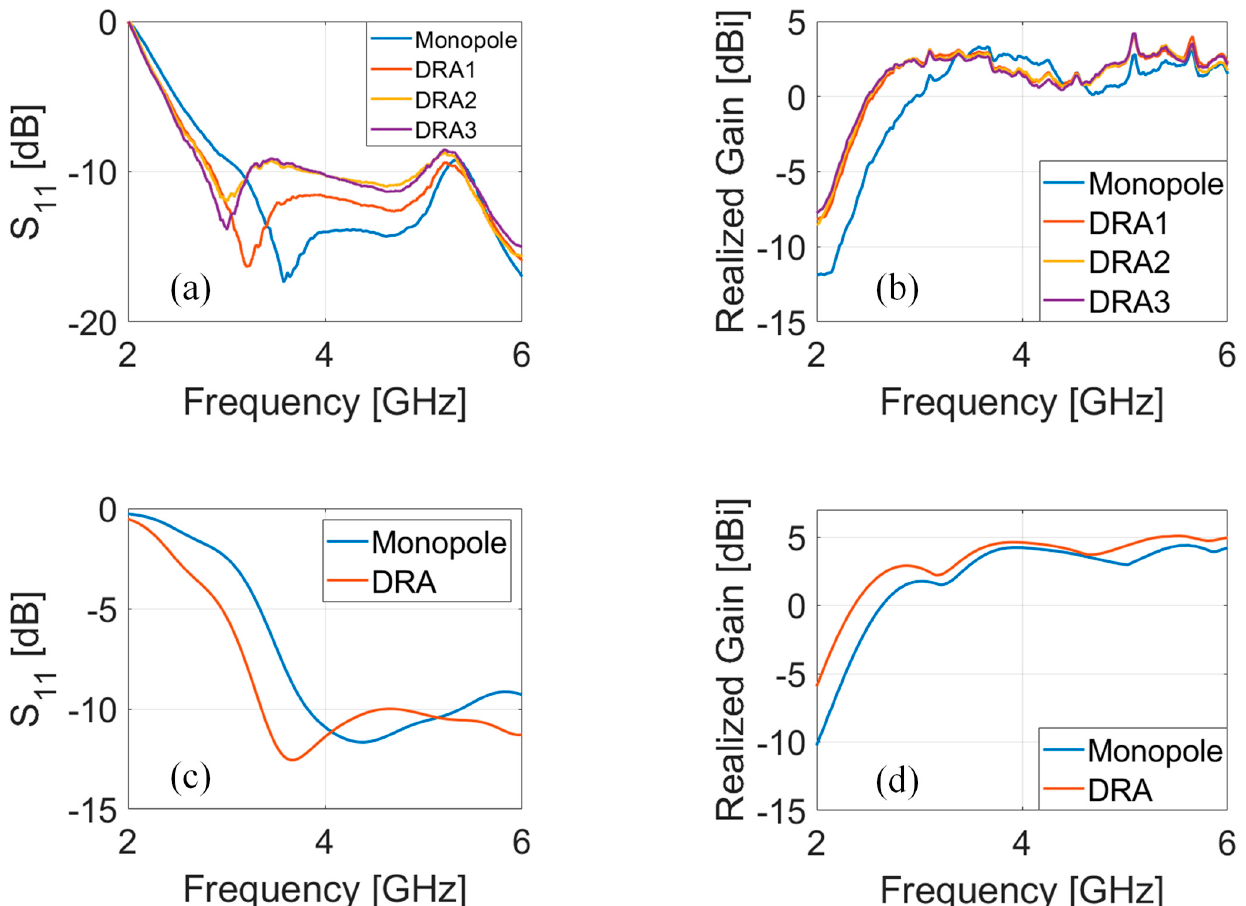
Figure 6. ( a ) Measured scattering parameter S 11 and ( b ) measured realized gain concerning monopole (blue curve), Clear V04 resin (DRA1, red curve), Grey V04 resin (DRA2, yellow curve), and Tough Blue V05 resin (DRA3, purple curve); ( c ) simulated scattering parameter S 11 and ( d ) simulated realized gain concerning monopole (blue curve) and Grey V04 resin (DRA, red curve).